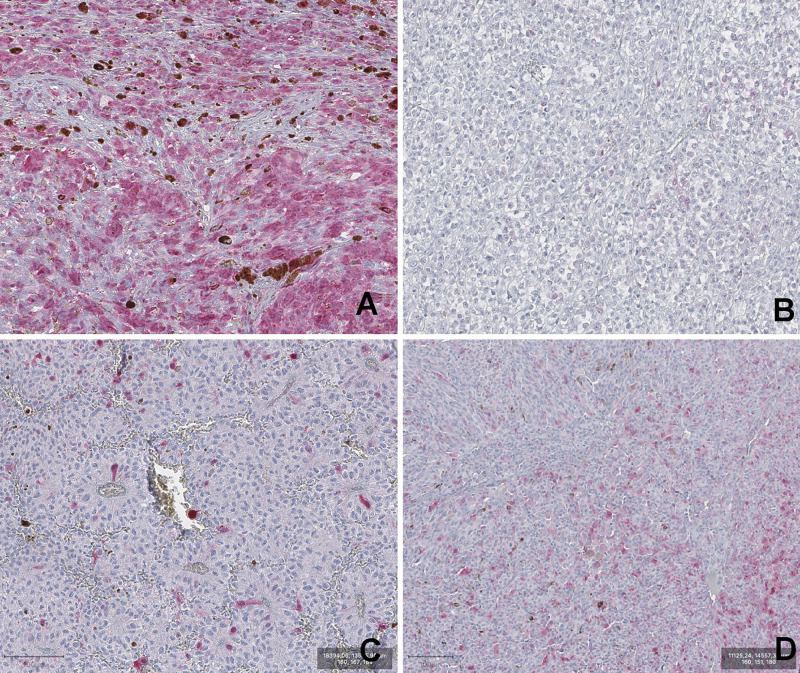
Representative images of P16INK4a IHC staining of Uveal melanoma samples. (A) DP (diffuse positivity). (B) negative. (C) low. (D) intermediate. (magnification 100×).